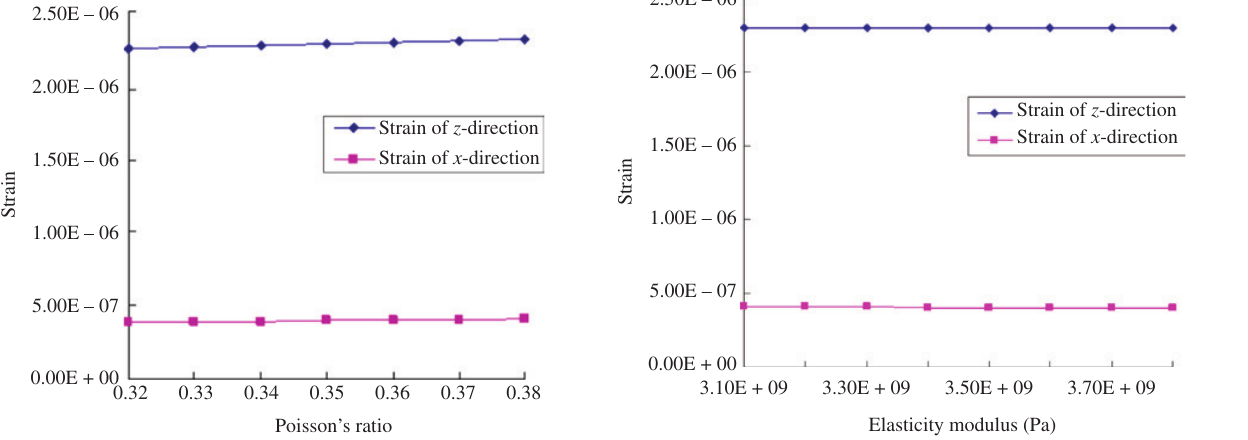
Figure 7: Relationship between piezoelectric Poisson’s ratio and strain of composite material ( U = 10 V).